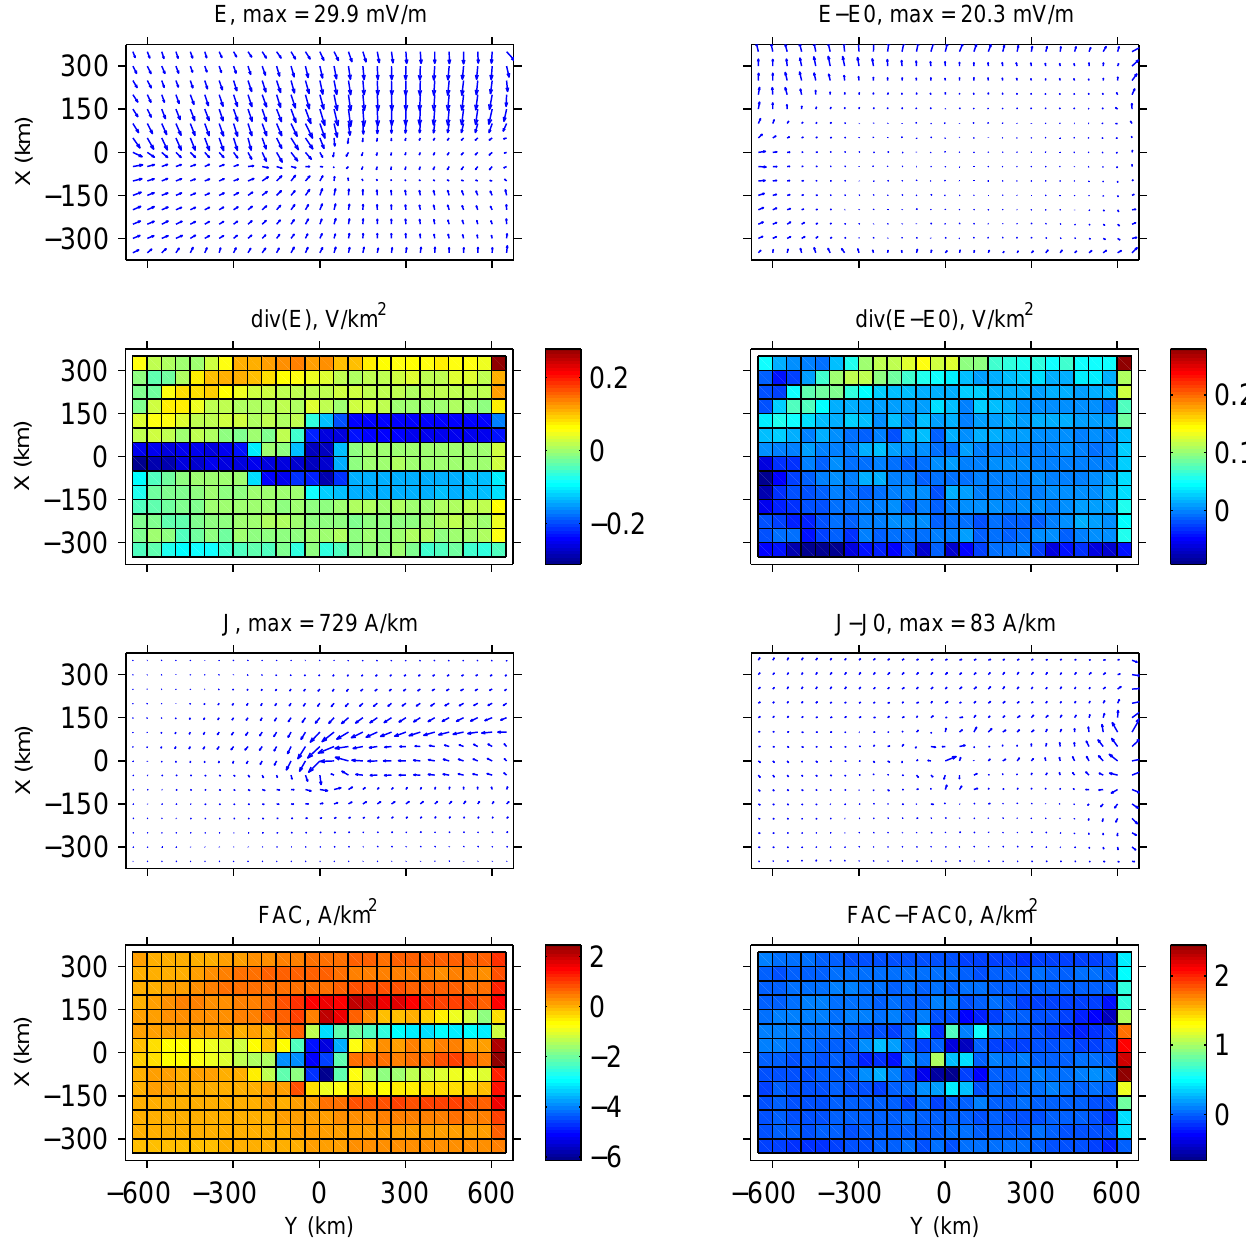
Fig. 10. Results of the CECS method for the WTS model. Layout is similar to Fig. 3. Note the different scales of the vector plots.